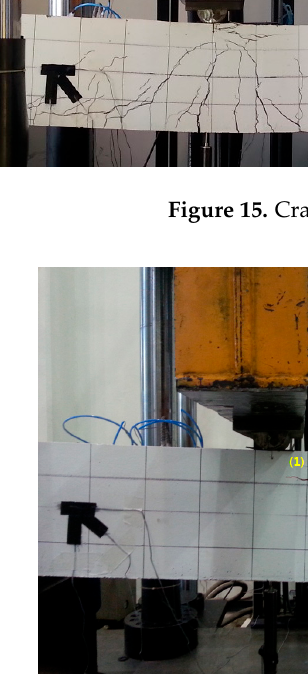
Figure 16. Crack pattern (P): ( 1 ) Initial crack formation on left at 140 kN; ( 2 ) Crack propagation on left bottom at 160 kN; ( 3 ) Crack formation and propagation to right side at 205 kN.